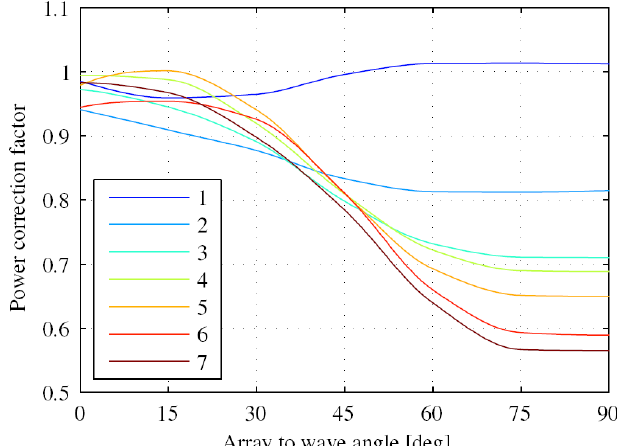
Figure 6. Correction factors for array as function of wave